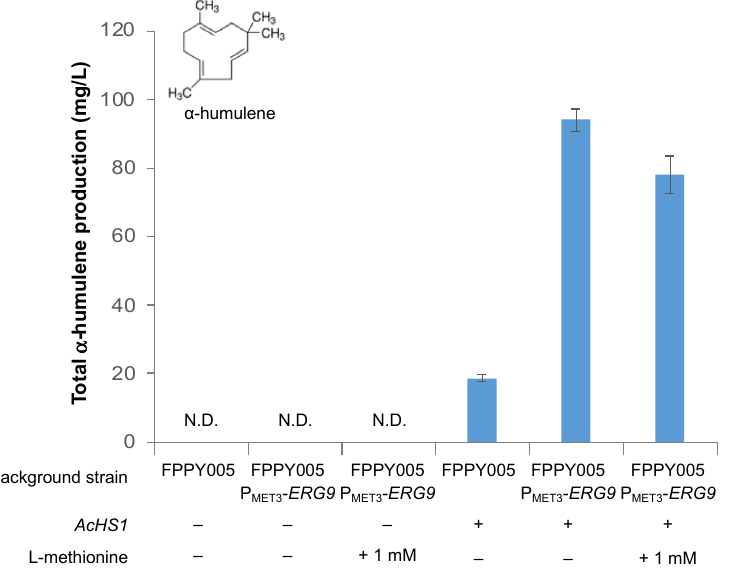
Figure 7. Effects of ERG9 repression on α -humulene production in engineered strains. + indicates that the gene was overexpressed. – indicates that the gene was not overexpressed. N.D. not detected.